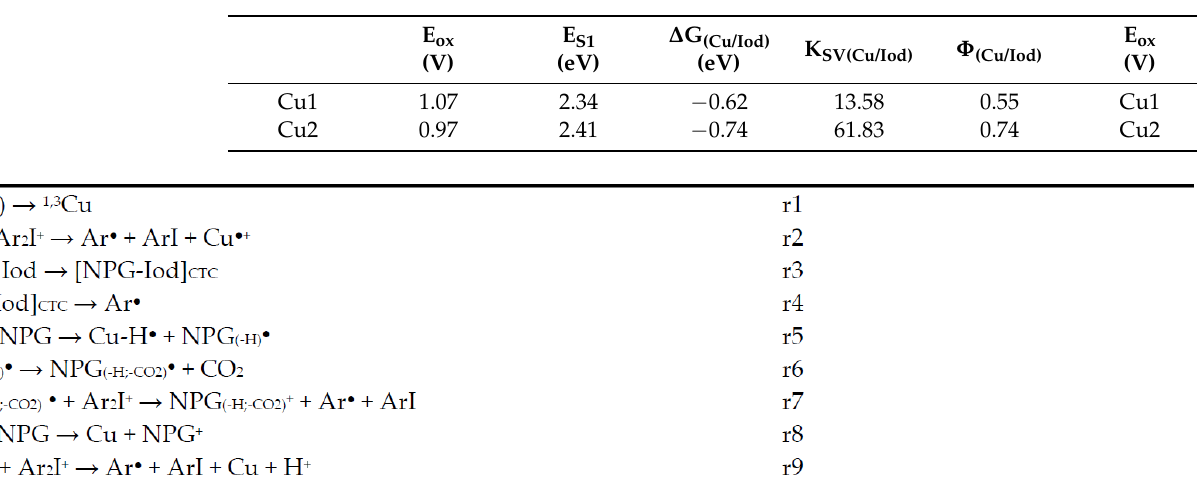
Figure 12. ( A ) Fluorescence quenching of Cu2 by Iod salt, ( B ) E S1 determination for Cu2, ( C ) Stern– Volmer coefficient determination of Cu2 quenched by Iod and ( D ) oxidation potential determination of Cu2. Table 8. Parameters characterizing the chemical mechanisms between Cu1 (or Cu2) and Iod. For Iod, a reduction potential of −0.7 eV was used for the ∆Get calculations.